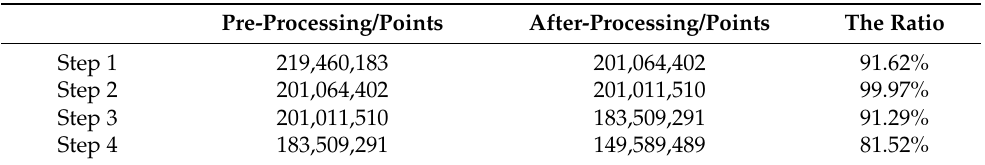
Table 1. Comparison of Automatic Identification System data volume before and after pre- processing steps.